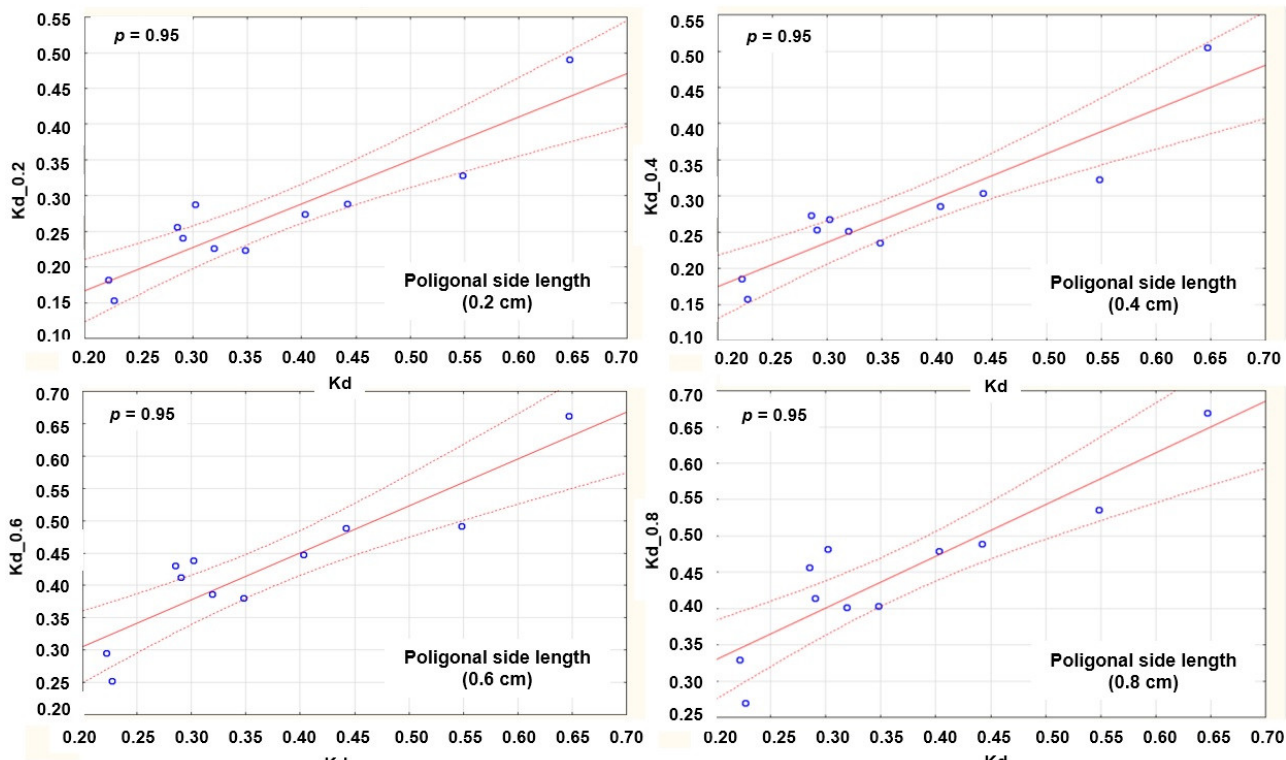
Figure 6. Linear correlation scatter graphs of real and simulated drape coefficients values with different polygonal mesh densities. p —reliability, Kd—drape coefficients of real measured fabrics, Kd_0.2—drape coefficients of fabrics simulated with polygonal side length of 2 mm, Kd_0.4—drape coefficients of fabrics simulated with polygonal side length of 4 mm, Kd_0.6—drape coefficients of fabrics simulated with polygonal side length of 6 mm, and Kd_0.8—drape coefficients of fabric simulated with polygonal side length of 8 mm. Table 5. Linear correlation analysis between the values of the drape coefficients of real fabrics and fabrics simulated with different polygonal mesh densities.